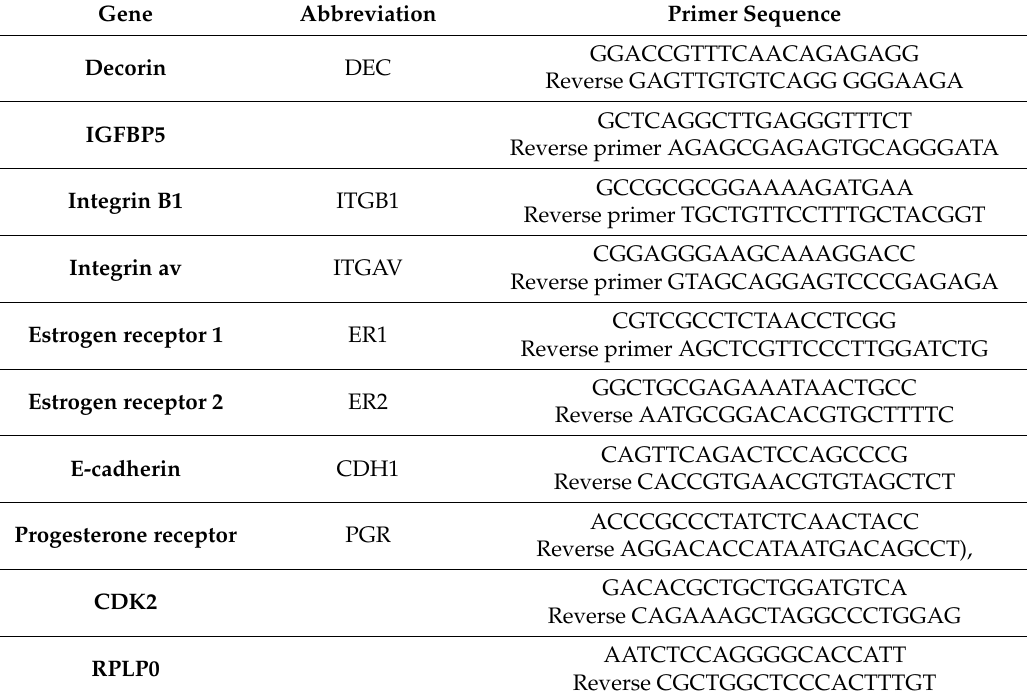
Table 5. Primer sequences used in the one-step